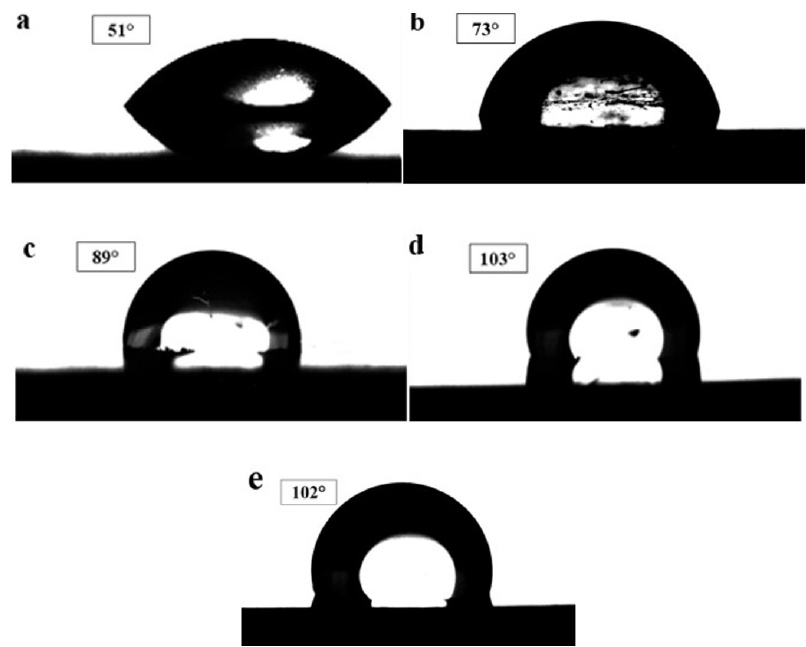
Figure 7. Water contact angle of: ( a ) bare 304 SS, ( b ) Nb-HT, ( c ) NbN-RT, ( d ) NbN-HT, ( e ) Nb/NbN- HT.